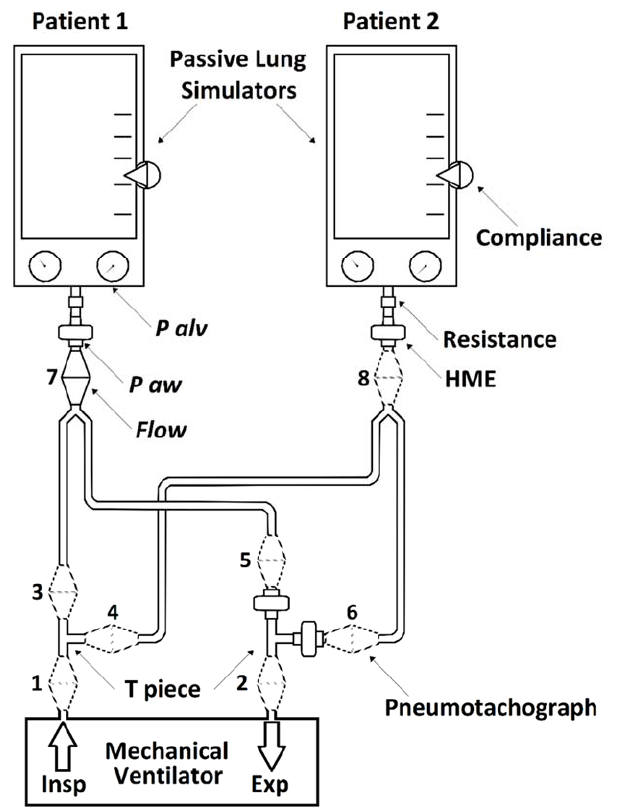
Figure 1. A schematic representation of the circuit tested. P alv = alveolar pressure (cmH 2 O), P aw = airway pressure (cmH 2 O), Flow = flow (L × s − 1 ), HME = heat and moisture exchanger, Insp = inspiratory, Exp = expiratory. Numbers indicate flows recorded in each section of the